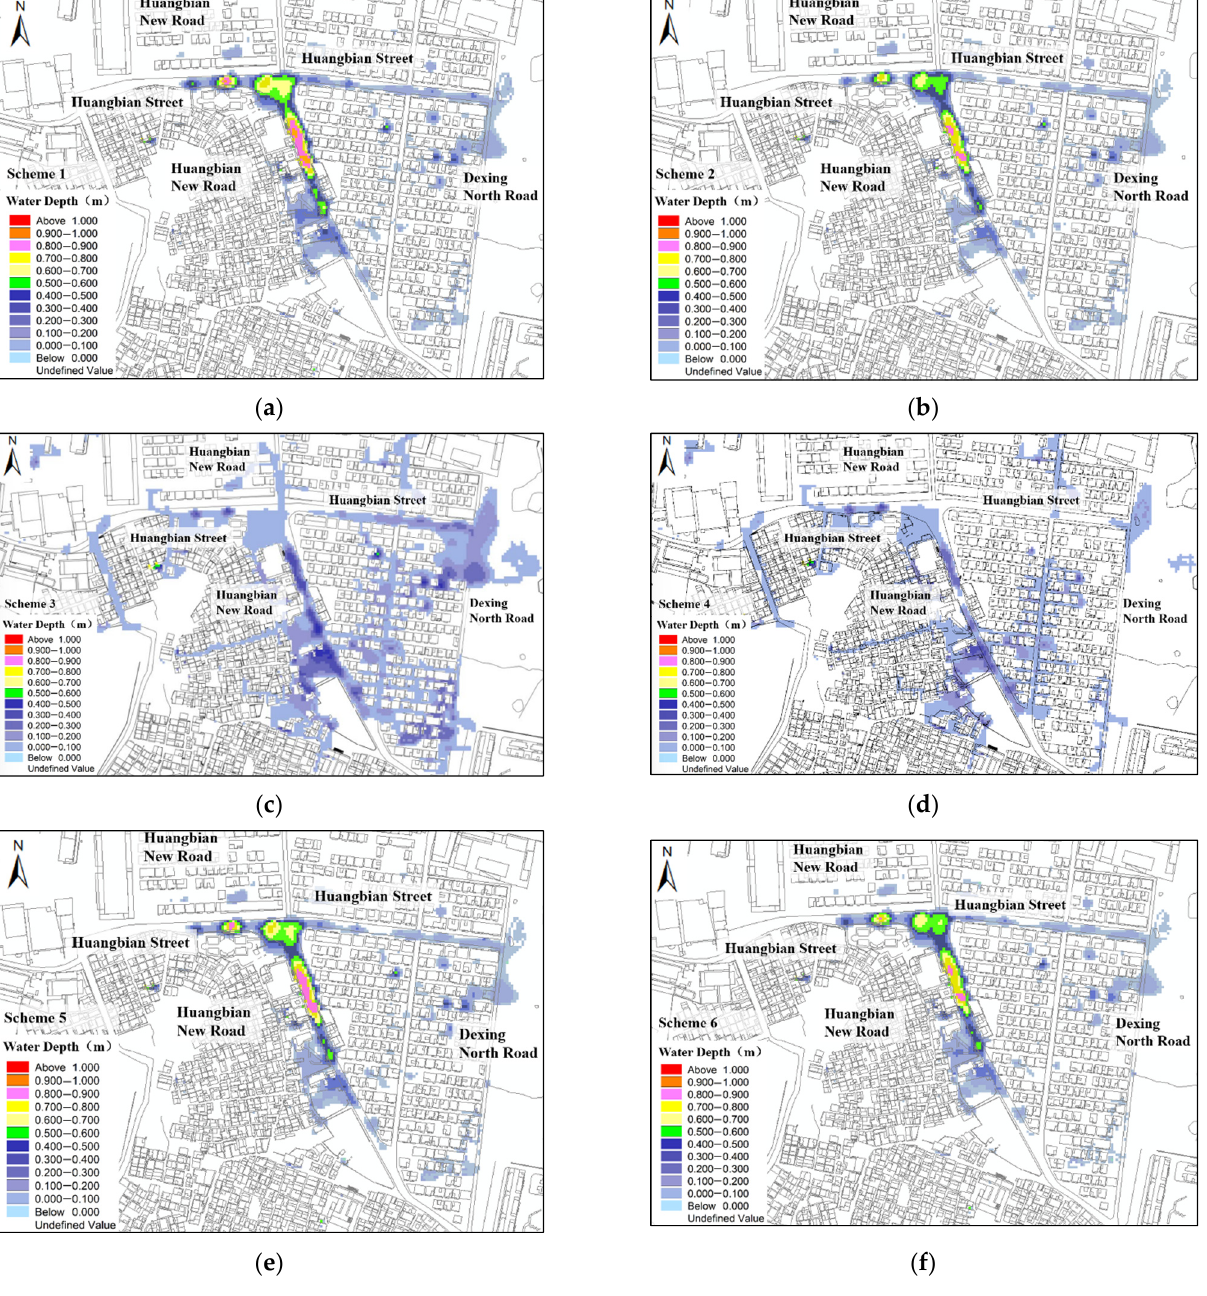
Figure 6. Schematics of different schemes against waterlogging under designed rainfall conditions. ( a ) Scheme 1; ( b ) Scheme 2; ( c ) Scheme 3; ( d ) Scheme 4; ( e ) Scheme 5; ( f ) Scheme 6.